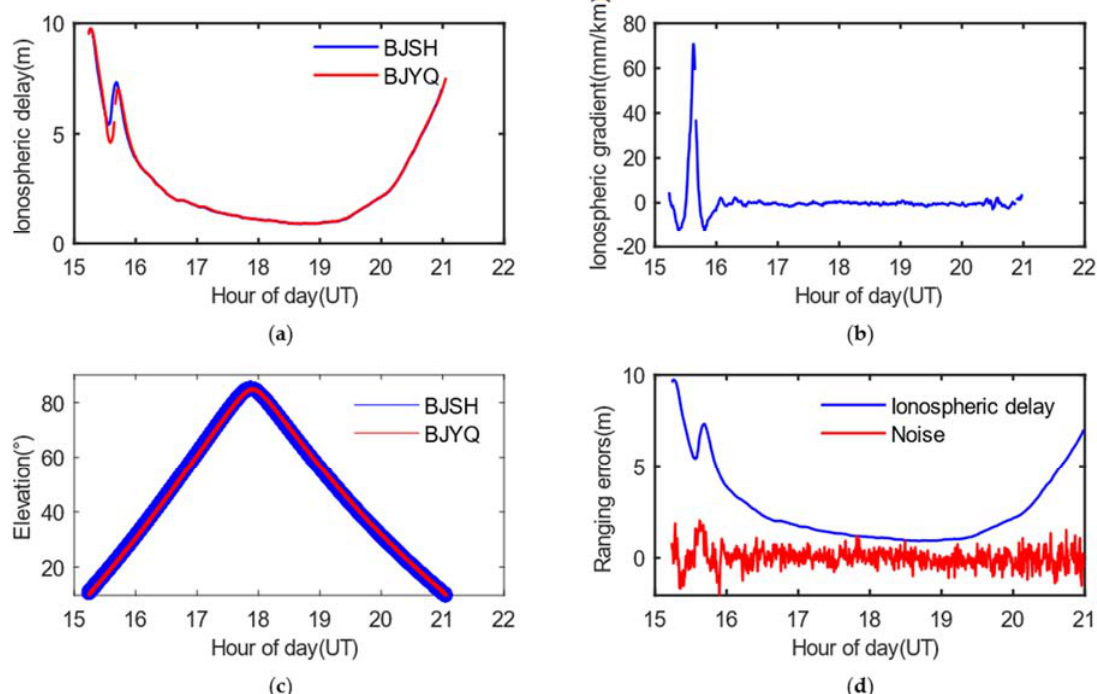
Figure 17. A typical ionospheric anomaly caused by geomagnetic storms in Beijing, China on 23 May 2012. Panels are: ( a ) The ionospheric delay measured on GPS PRN 10 at BJSH and BJYQ stations; ( b ) the ionospheric gradient calculated along the baseline between the two stations; ( c ) the satellite elevations of PRN 10; ( d ) the observation ranging errors of PRN 10 at BJSH station. The amplitude of noise is briefly limited to 1.5